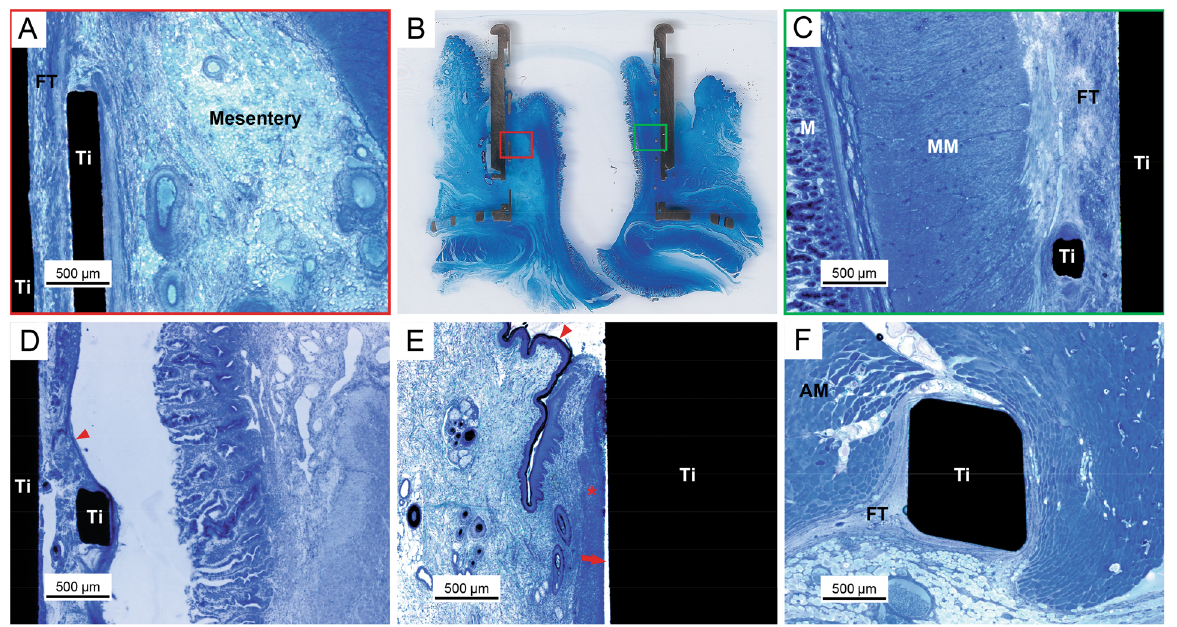
Fig. 3 A – C Light micrographs showing the integration between the intestine and the inner mesh and cylindrical surface of the titanium (Ti) port in an ileostomy model (EBM12, 9 weeks). A On the anti- mesenteric side, integration was observed between the external part of the intestine and the inside of the titanium cylinder and the mesh. The vascularised fi brous tissue (FT), without signs of in fl ammation, fi lled the area around the mesh structure and merged with the outer tissue of the ileum. No major mucosal downgrowth was detected. M = intest- inal mucosa, MM = muscularis. C On the opposite side, the mesentery ran along the mesh and integrated with the vascularises fi brous tissue (FT) around the mesh. No in fl ammation was detected. D Light micrograph showing the absence of integration between the intestine and the inner mesh and cylindrical surface of the titanium port (EBM10, 13 weeks). The intestinal mucosa (M) migrated downwards and separated from the material surface by material-adherent tissue